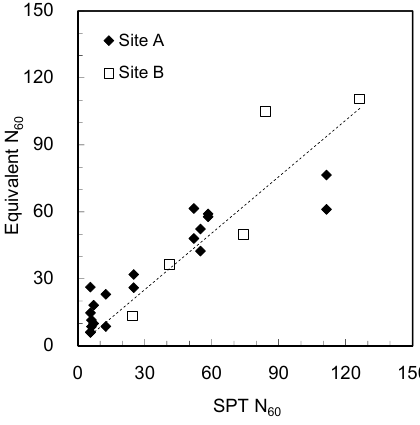
Figure 10. Equivalent N 60 versus SPT N 60 .